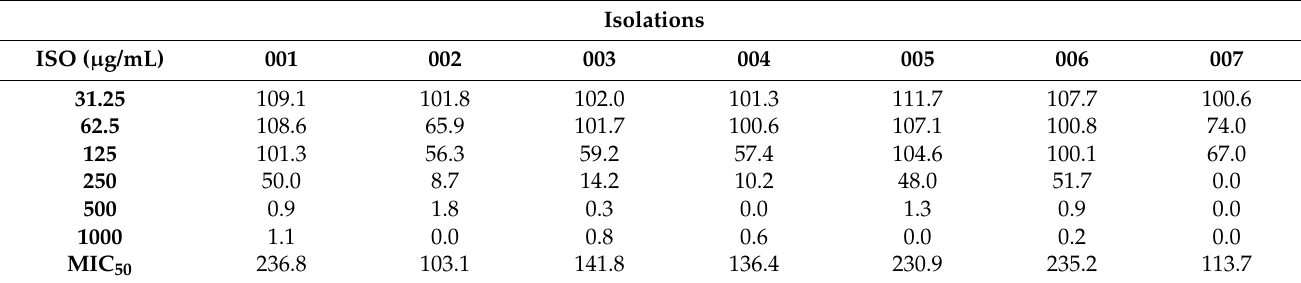
Table 2. Viability percentages with MTT.